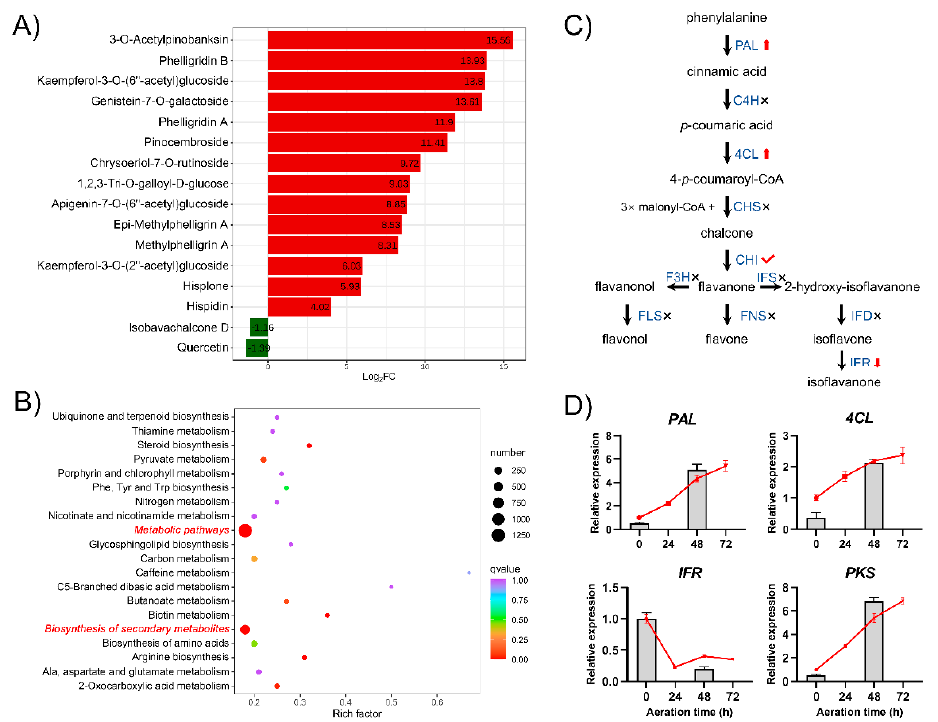
Figure 4. Metabolomics and transcriptome analysis of S. baumii mycelia aerated for 0 and 48 h. ( A ) Sixteen differential metabolites in the mycelia aerated for 0 h and 48 h. ( B ) Top 20 KEGG pathways with the most significant enrichment for mycelia aerated for 0 and 48 h. ( C ) Flavonoid biosynthesis pathway in S. baumii . Enzymes in the pathway are shown in blue. The red arrows up or down indicate increased or decreased gene expression after aeration, the red check mark indicates that the gene expression level has no significant change, and the black crosses indicate absence of such a homolog in S. baumii . PAL , phenylalanine ammonia lyase; C4H, cinnamate 4-hydroxylase; 4CL, 4-coumarate-CoA ligase; CHS, chalcone synthase; CHI, chalcone isomerase; FNS, flavone synthase; F3H, flavanone-3-hydroxylase; FLS, flavonol synthase; IFS, 2-hydroxy isoflavone synthase; IFD, 2- hydroxyl isoflavone dehydrase; IFR, isoflavone reductase. ( D ) Verification of differentially expressed genes by quantitative real-time polymerase chain reaction (qRT-PCR). Bars show transcriptome data and lines show qRT-PCR data. PKS , polyketone synthase